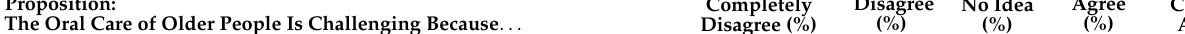
Table 5. Nurses’ ( n = 18) responses (in percentages) to the items of oral health-related knowledge before and after intervention. Proposition: The Oral Care of Older People Is Challenging Because . . .